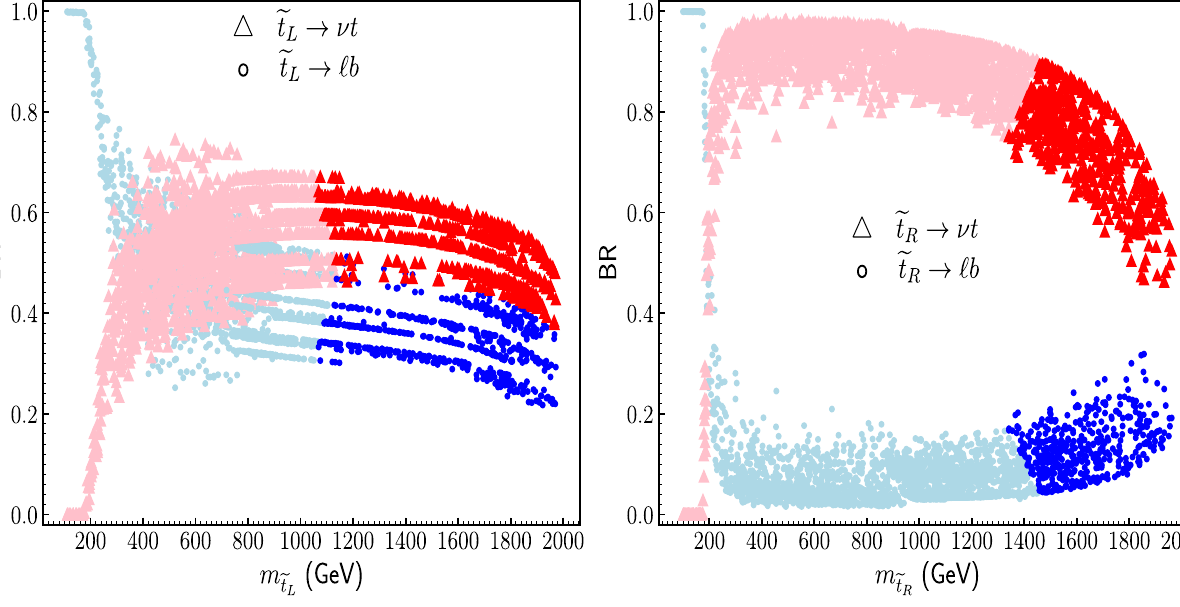
Fig. 5 Points of Fig. 4, but showing for them the sum of branching ratios of stop LSP decaying to (cid:10) b (blue points) and ν t (red triangles) versus the stop mass m (cid:4) t . Light (dark)-red and blue points do not fulfill (fulfill) the LHC